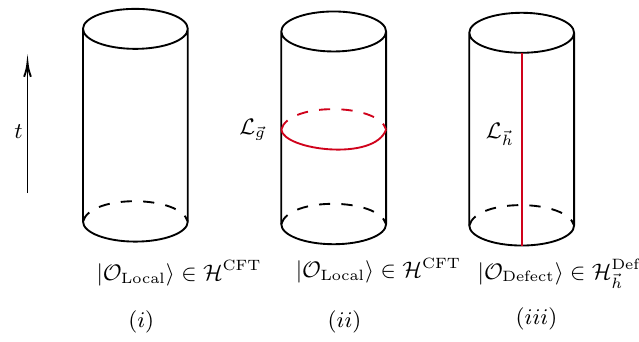
Figure 3 . The CFT on S 1 × R : (i) The code subspace maps to the CFT states corresponding to genuine local operators (ii) A CFT logical operation: wrapping the spatial slice with a symmetry defect, L , implements the symmetry on H CFT (at the level of the code, the logical operation is ~g Bulk trivial). (iii) The complement of the code subspace in the n -qubit Hilbert space: a state in the L ~h -defect Hilbert space (here 2 ~h = ~ 0